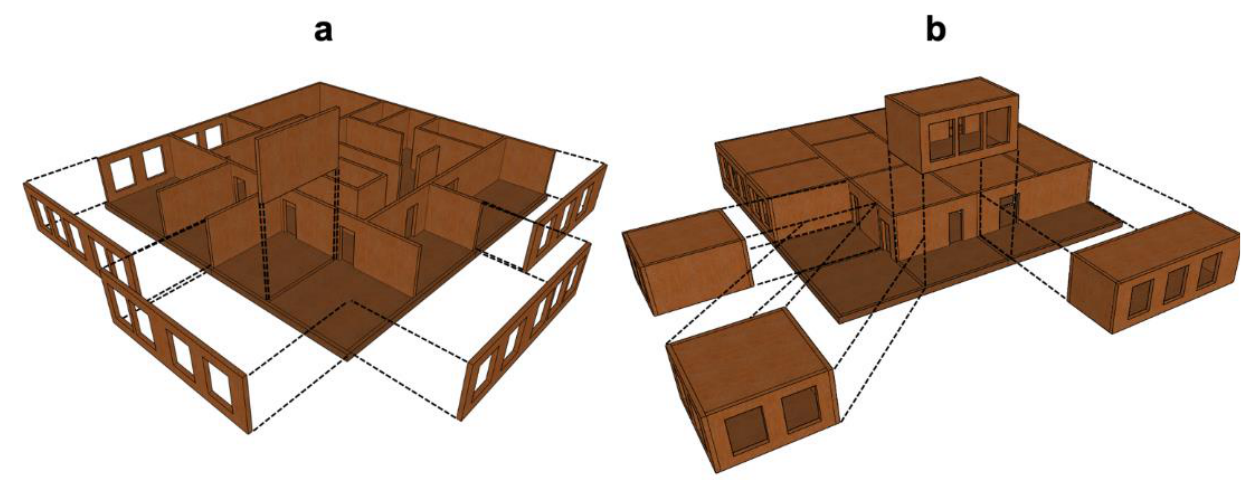
Figure 5. Modular mass timber systems: ( a ) planar and ( b ) volumetric.